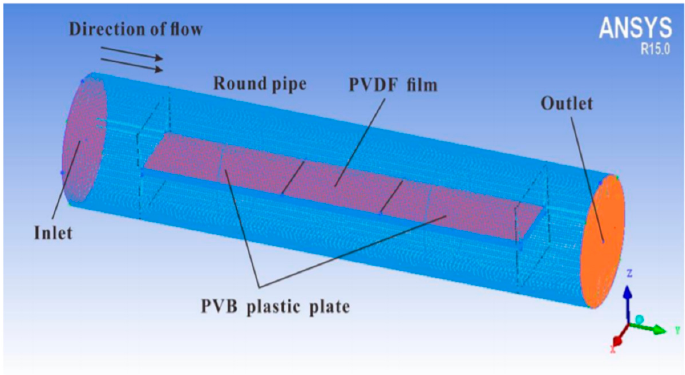
Figure 20. Modeling and meshing of fluid domain. Reprinted with permission from [135].